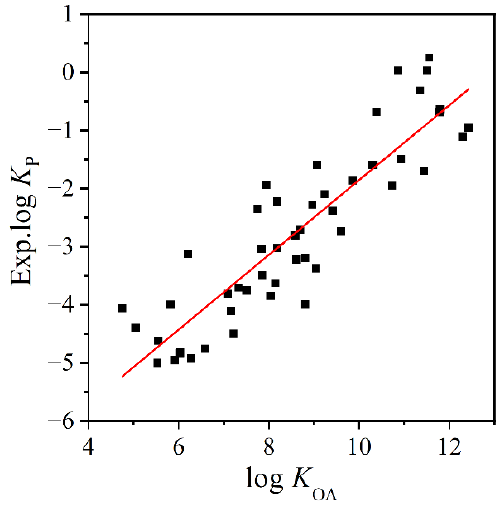
Figure 1. The fitting plot between experimental log K P values and log K OA values.